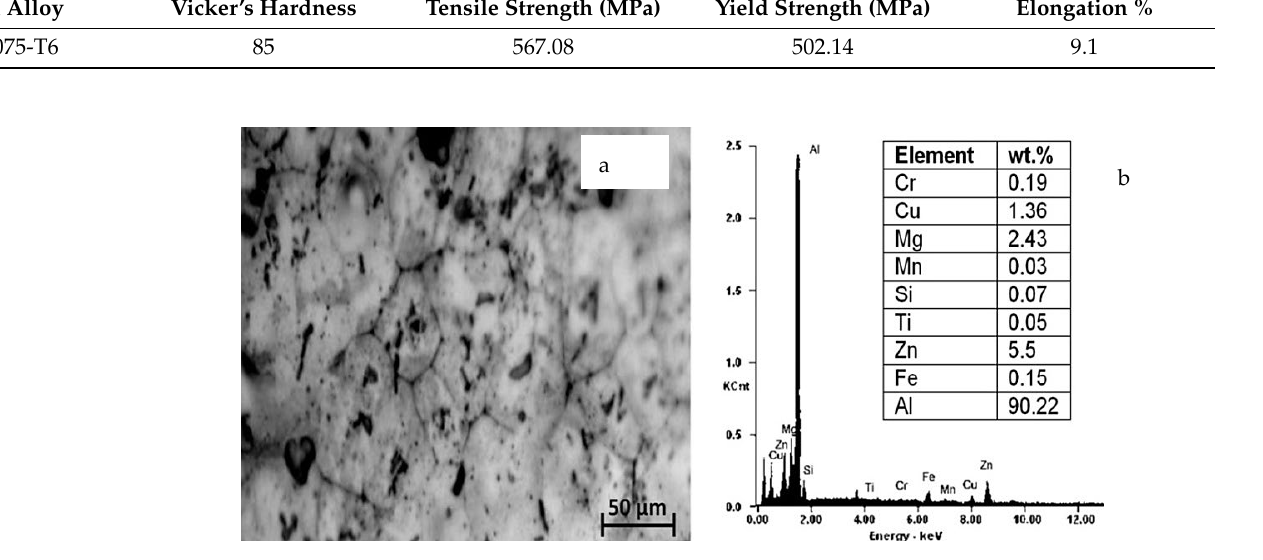
Figure 3. ( a ) SEM image showing microstructure; ( b ) EDS showing chemical composition of Alu- minium alloy 7075-T6.